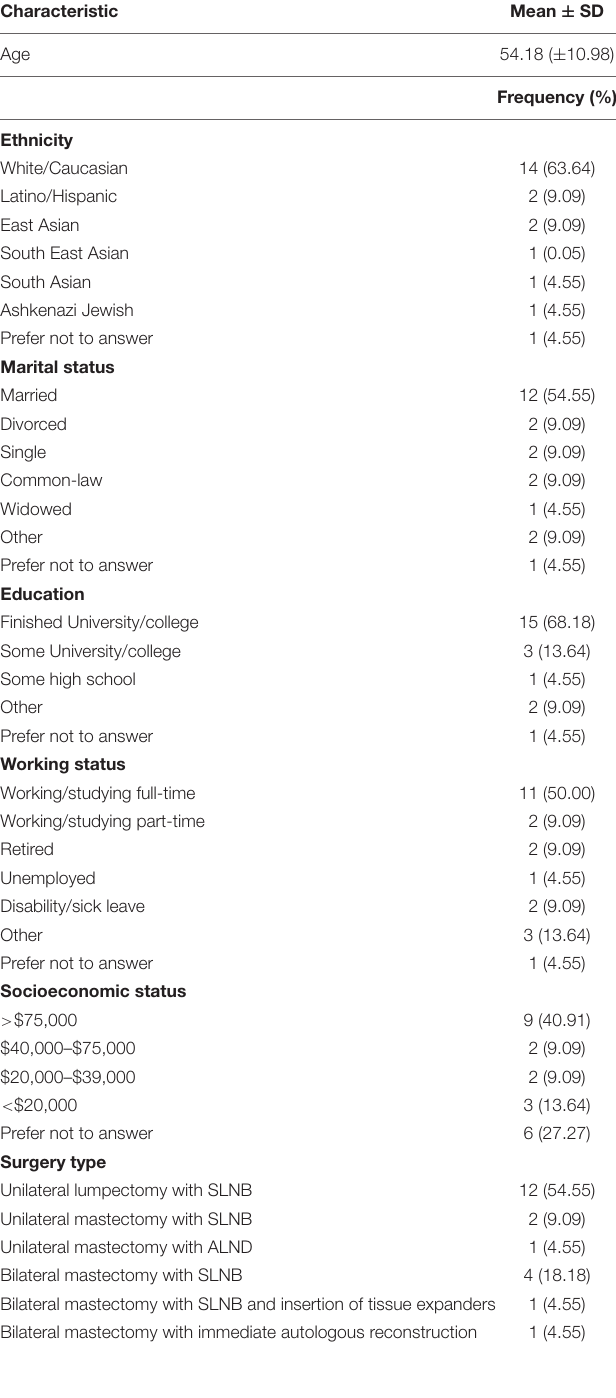
TABLE 1 | Participant baseline characteristics ( n =